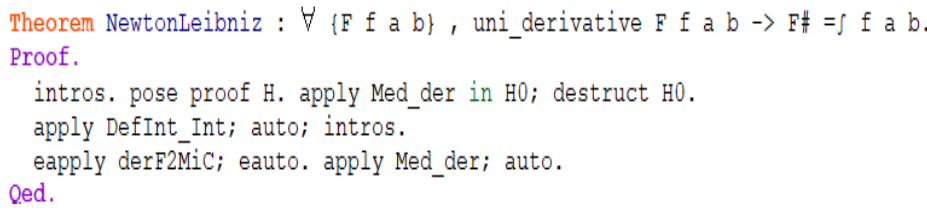
Figure 1. The formalization of Newton Leibniz formula.